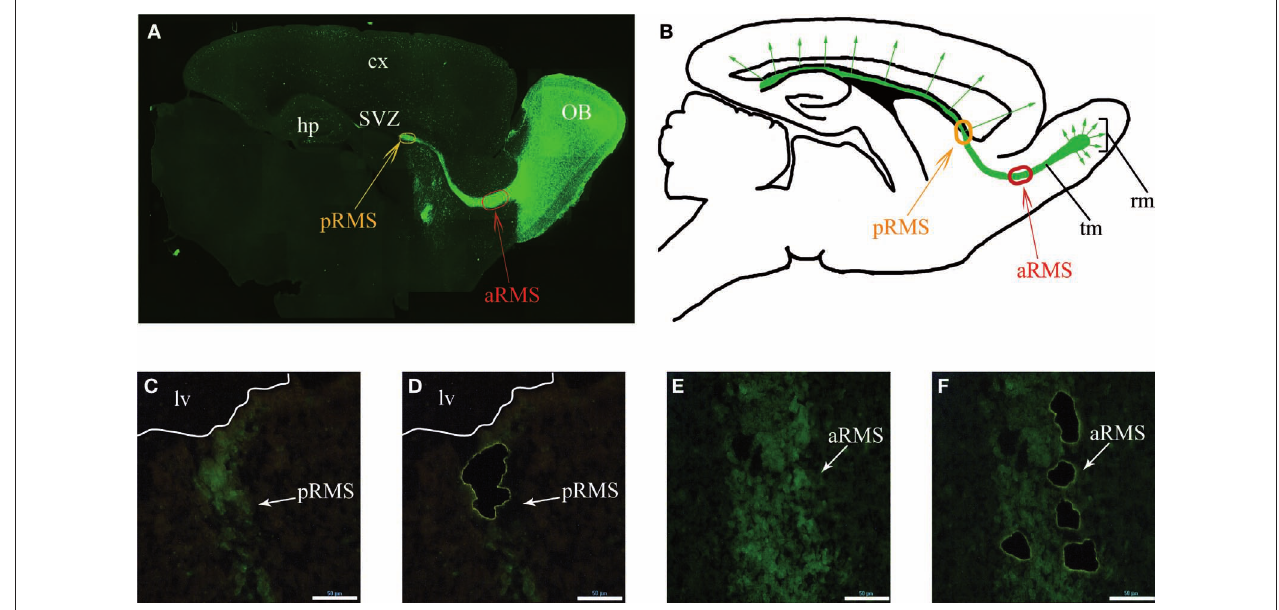
FIGURE 1 | Identifi ed RMS areas serving as source for gene expression microdissection of green cells from pRMS and aRMS. (C) and (D) pRMS before analysis. (A) Sagittal view of 5HT3 -EGFP mouse RMS stained with anti-EGFP and after EGFP-neuroblast microdissection, respectively. White line is a A antibodies. Orange and red ovals indicate the posterior and anterior RMS (pRMS and aRMS), respectively. (B) Scheme of sagittal view of section shown in (A) , modifi ed from Inta et al., (2008). In the RMS neuroblasts migrate tangentially while after reaching the OB they migrate radially. (C–F) Laser